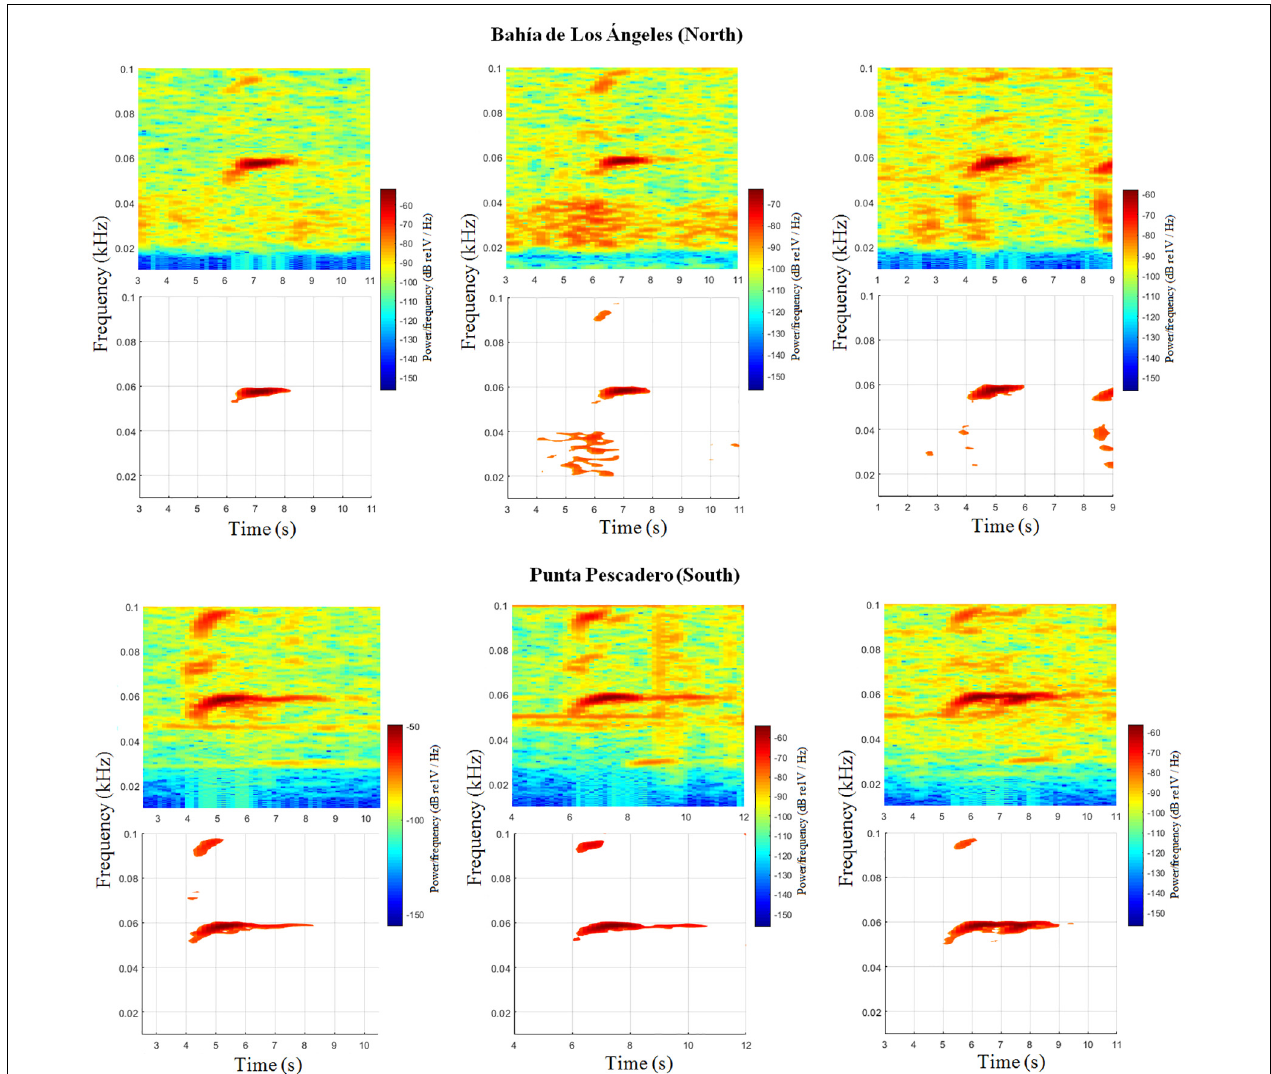
FIGURE 5 | Examples of Be4 calls from the north (Bahía de Los Ángeles, Baja California) and from the south (Punta Pescadero, Baja California Sur). Spectrograms 2D showed for each call without (top) and with (bottom) the threshold cut at 24 dB from the maximum amplitude value. Spectrograms: Butterworth (2nd order) high-pass filter at 40 Hz cut off, Hamming window size 2048, 85% overlap, and a frame of